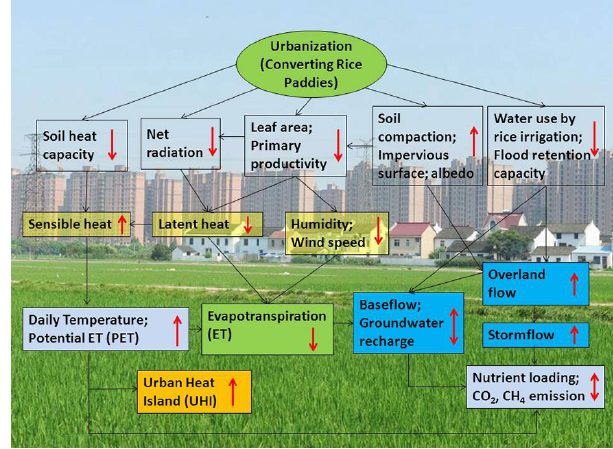
Figure 1. A conceptual model illustrating the potential hydrologic and environmental impacts of converting rice paddies to urban uses in the Yangtze River Delta region. Arrows represent directions (up or down or both) of change (background photo credit: http://blog.